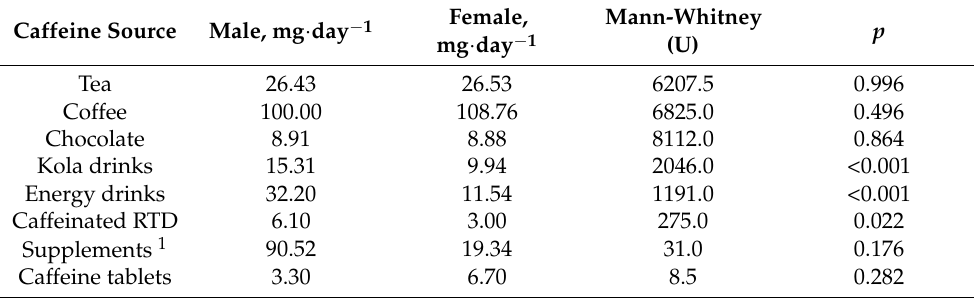
Table 2. Estimated daily caffeine consumption from caffeine sources by